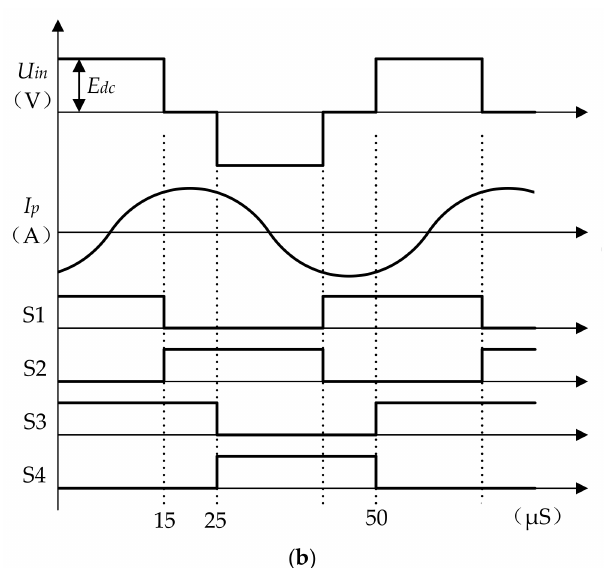
Figure 2. Topology of the inductive power transfer (IPT) system. ( a ) Power converter schematic of IPT system; ( b ) Switching signals, control signals, and electrical waveforms.